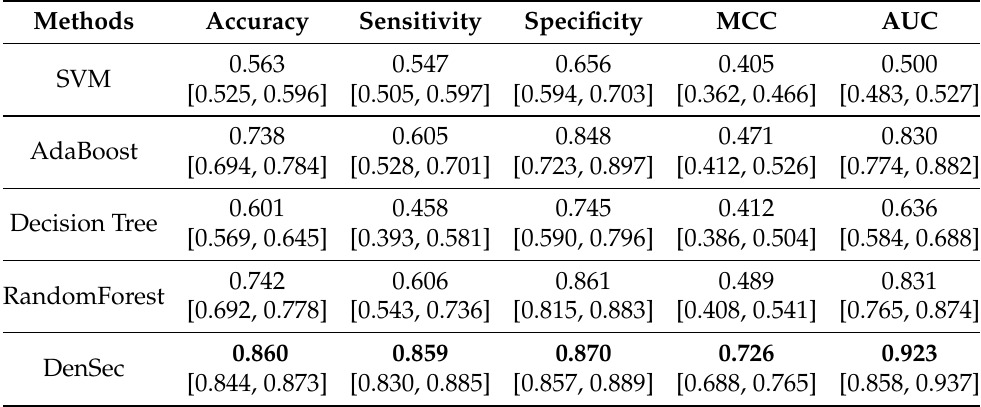
Table 2. The performance evaluation based on testing dataset, grouped by several machine learning